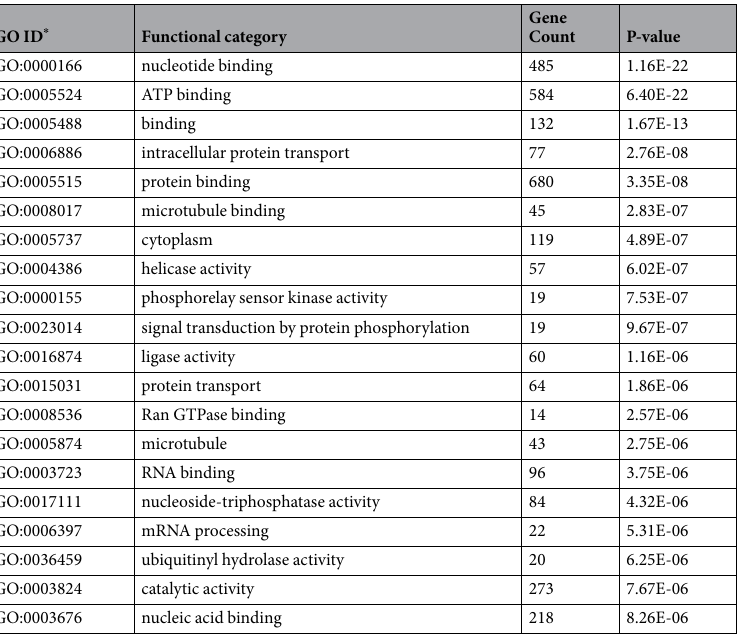
Table 2. GO categories of circRNA-host genes in soybean. * Top 20 GO terms with the threshold of P-value < 0.05 were listed.